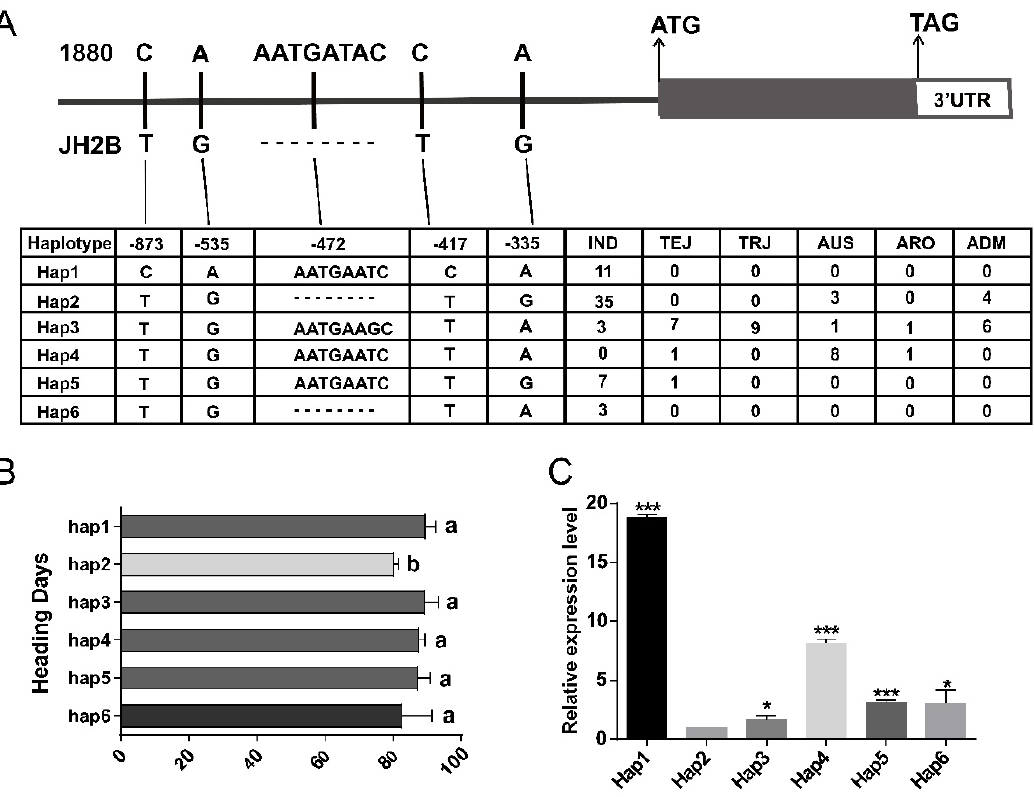
Figure 7. Haplotype analysis of OsHd8 . ( A ) Haplotype analysis of OsHd8 from 101 rice varieties; IND means indica , TEJ means temperate japonica , TRJ means tropical japonica , AUS means aus , ARO means aromatic , ADM means admixed ; ( B ) Analysis of heading date in representative varieties with six haplotypes. n = 11 in Hap1, n = 42 in Hap2, n = 27 in Hap3, n = 10 in Hap4, n = 8 in Hap5, and n = 3 in Hap6; ( C ) The relative expression level of the six haplotypes. Values are means ± SEM (n = 3), The asterisks indicate significant differences (*, p < 0.05; ***, p < 0.001; Student’s t-test).